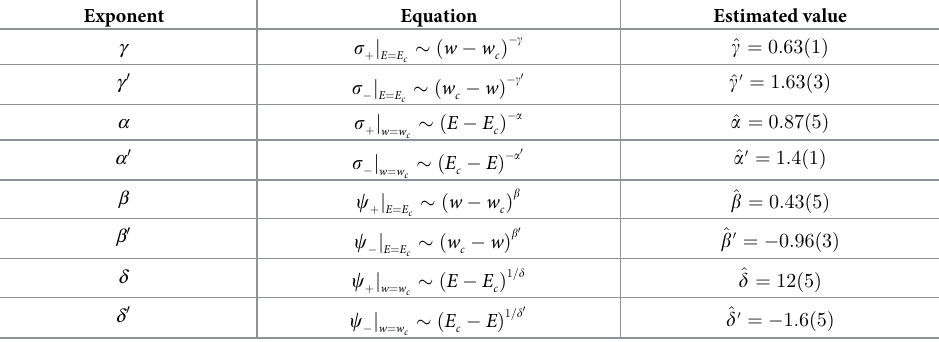
Table 1. Estimated exponents. The terms including σ denote the standard deviation (size of fluctuations) of spread size and their dependence on excitability ( E ) and connectivity strength ( w ) in the probabilistic model. The terms including ψ relate to the order parameter (normalized spread size) and their dependence on excitability and connectiv- ity strength. The numbers in parentheses after each value represent the error in the last digit, e.g 1.63(3) = 1.63 ± 0.03. Exponent Equation Estimated value